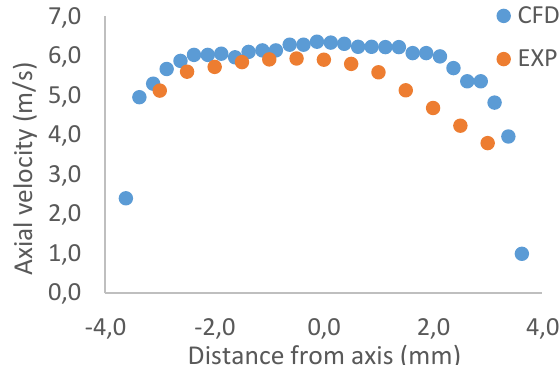
Fig. 3. Comparison of axial velocities obtained by CFD and LDA measurements. The velocities studied in coronal plane of the child airway model. Positive distance from axis corresponds to left side of the model.